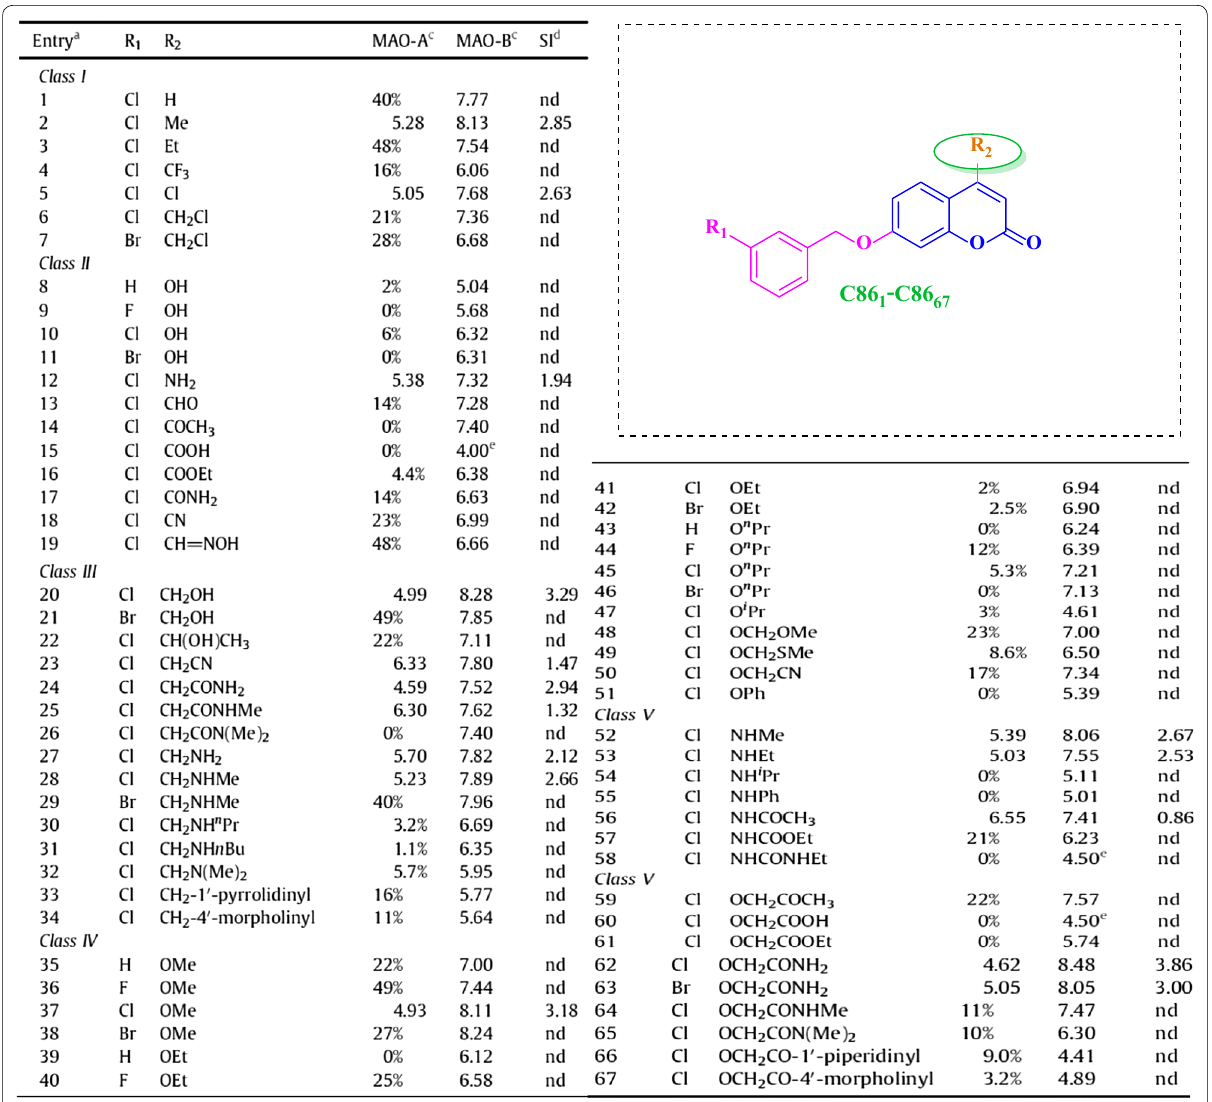
Fig. 71 Molecular structures of the compounds C86 1 – C86